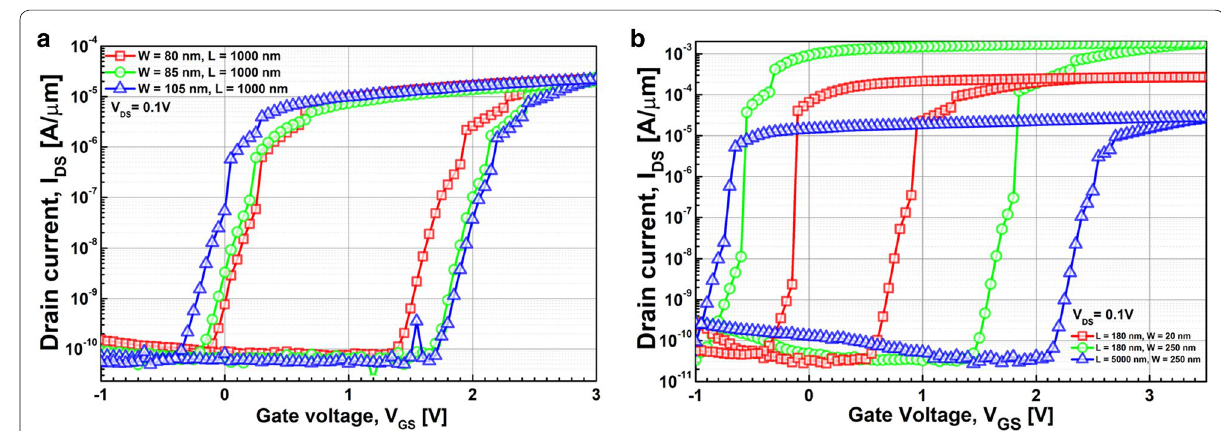
Fig. 7 Measured drain current vs. gate voltage of a FE-FDSOI, b FE-FinFET, for various device dimensions of baseline